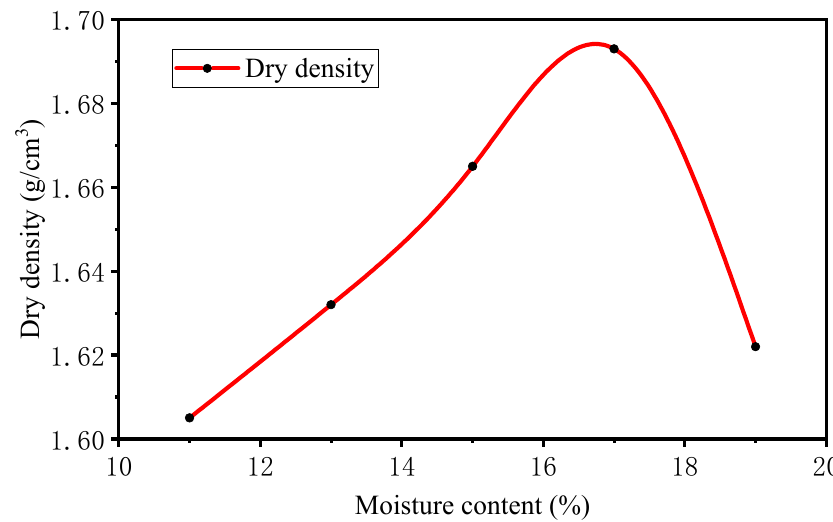
Figure 5. Moisture content and dry density curve of aeolian sand. Table 3. Mix compositions of solidified aeolian sand samples.